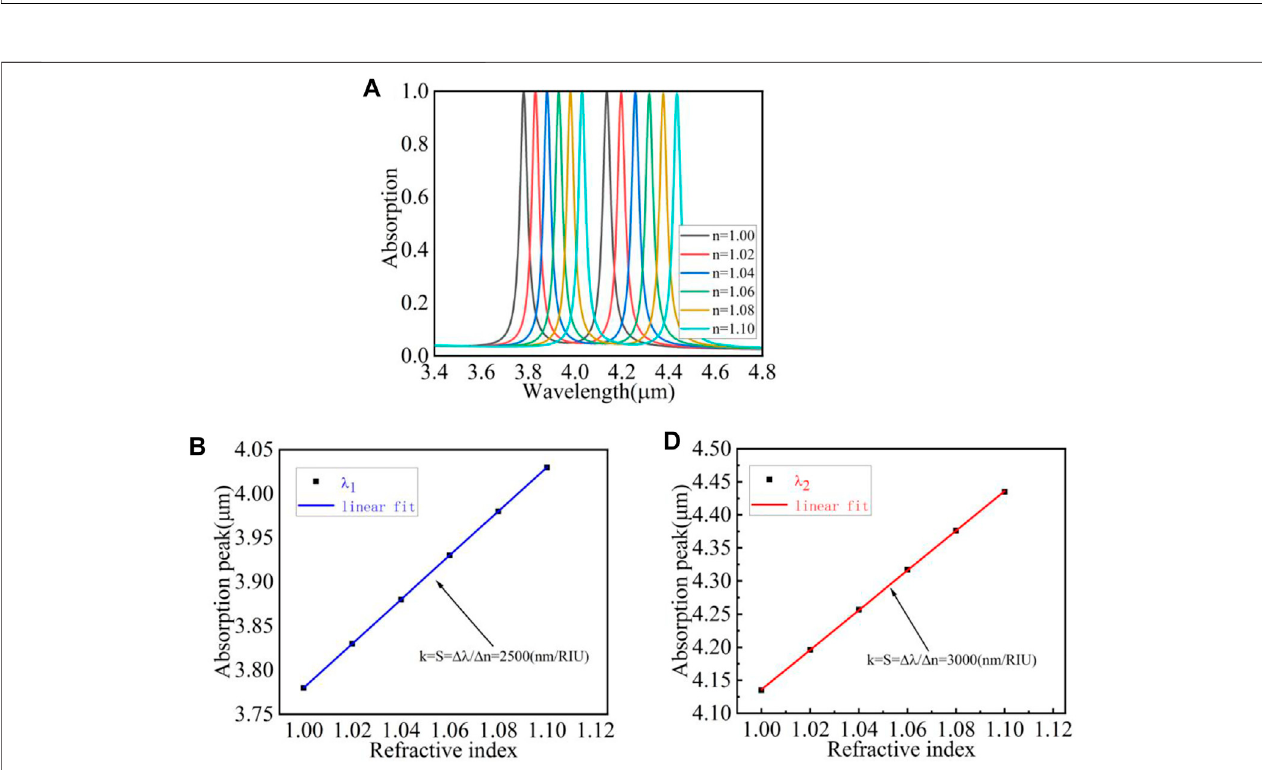
FIGURE 7 | (A) When changing the environmental background refractive index, the absorption spectrum of the grating. (B) For the wavelength λ 1 , the peak wavelength relationship diagram corresponding to the refractive index change. (C) For the wavelength λ 2 , the peak wavelength relationship diagram corresponding to the refractive index